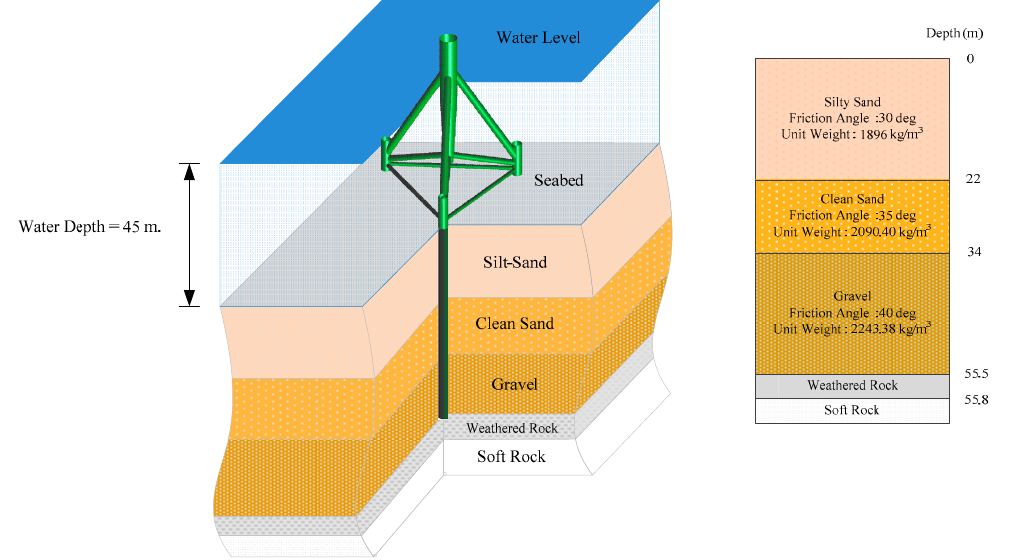
Figure 16. The tripod support structure for pile-soil-structure interaction (PSSI) modeling.